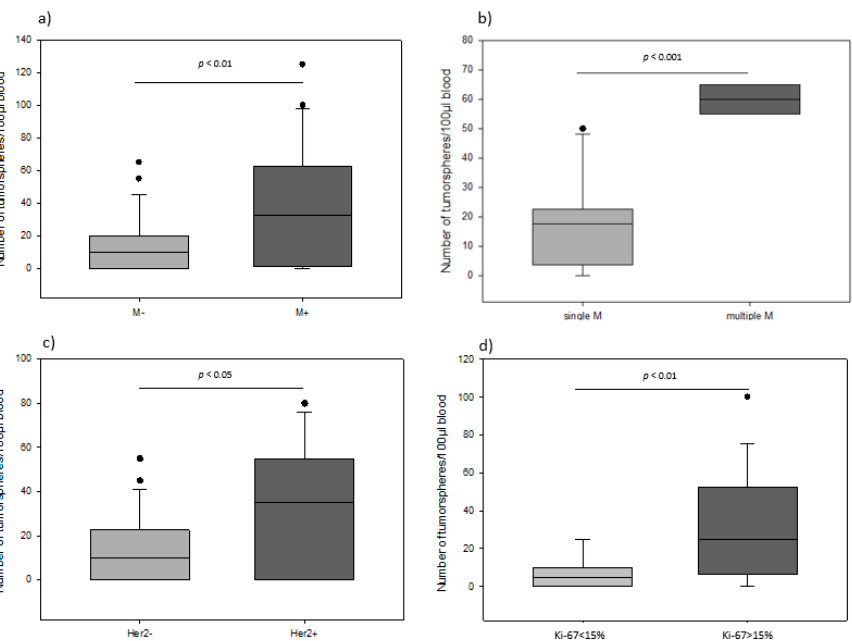
Figure 3. ( a ) Box plot analysis of the number of tumorspheres in patients without and with metastatic disease. ( b ) Box plot analysis showing the number of tumorspheres in patients with single and multiple metastases. ( c ) Box plot analysis of the number of tumorspheres in patients negative and positive for Her2-neu in primary tumor. ( d ) Box plot analysis showing the number of tumorspheres in patients with Ki-67 < 15% and >15% in primary tumor. The horizontal line in box-plot depicts median value. Dots specify outliers.